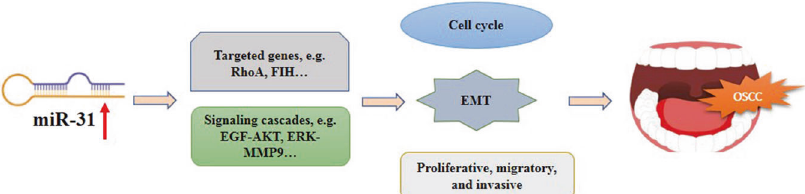
Fig. 3 Diagram of the main fi ndings of this review. Upregulation of miR-31 involves in the development OSCC by interacting with the targeted genes and signaling cascades that affect the cell cycle, EMT, and cell growth of the cancer